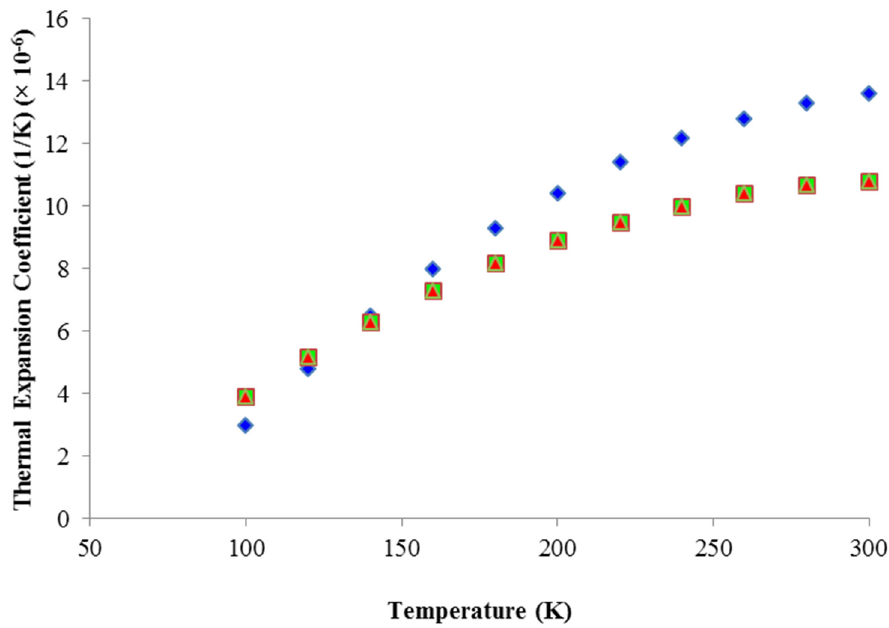
Figure 22. Thermal expansion coefficient as a function of absolute temperature for the biaxial laser materials BYF (blue), KGW (green), and KYW (red) [29]. All data are reported for the b -axis and for undoped crystals.